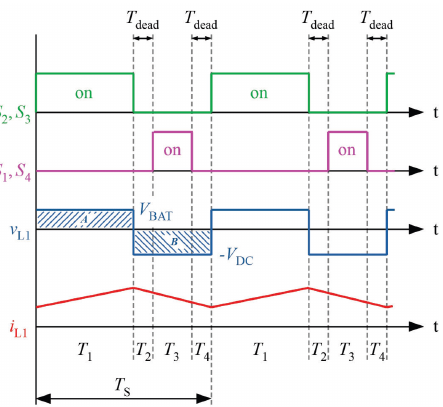
Figure 14. Active switch states, inductor voltage and inductor current for BAT and DC–link. The co-relation between the battery voltage ( V BAT ) and the DC–link voltage ( V DC ) can